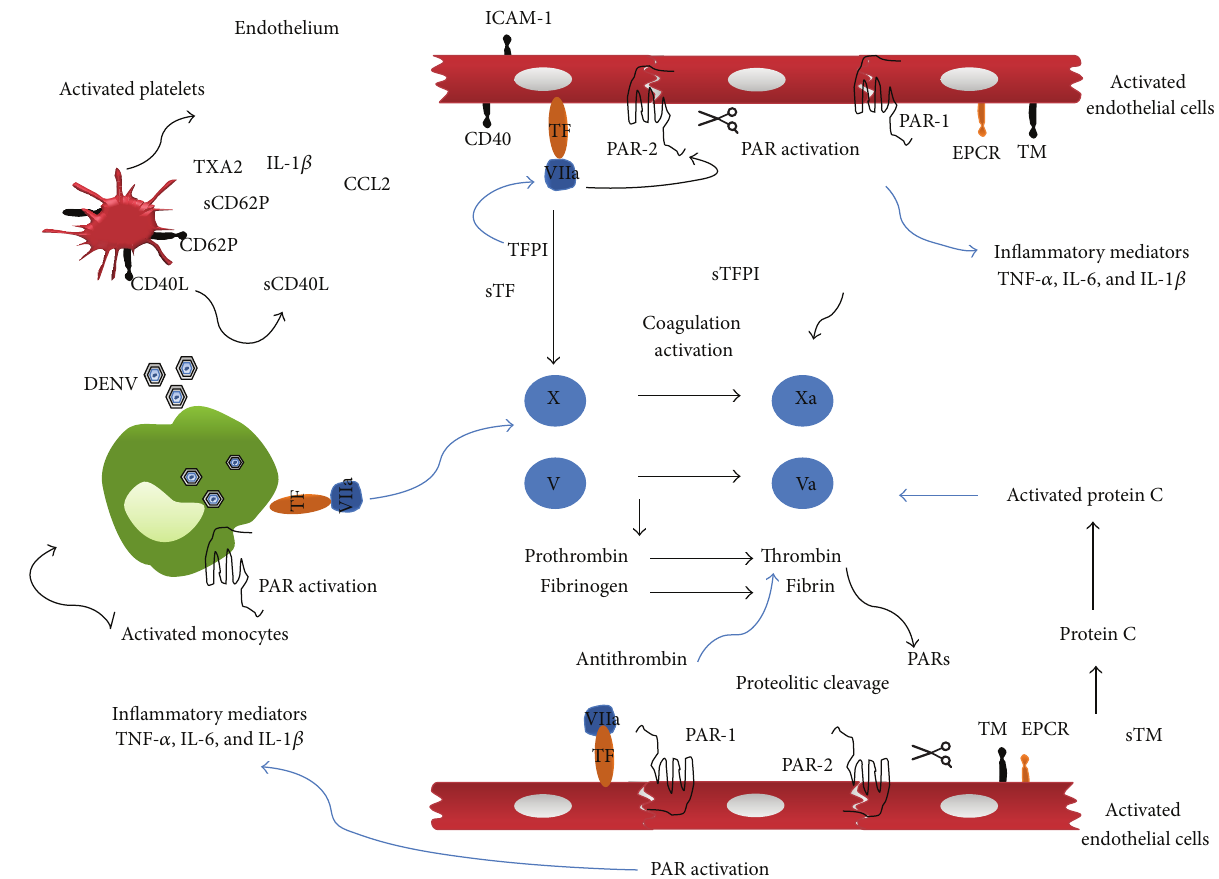
Figure 1: Coagulation and inflammatory response activation during dengue. DENV infection is often associated with coagulation disorders. Thecoagulationsystemisactivatedbythehostimmuneresponse.Theactivationofcoagulationsystemleadstothegenerationofthrombinand intracellular signaling through PAR; platelet and monocyte activation and recruitment; and increased TF expression on the endothelium and monocytes. The following anticoagulant pathways balance this system: the protein C system, antithrombin (AT), and Tissue Factor Pathway Inhibitor (TFPI). Increased CD62P expression in platelets from dengue patients indicates platelet activation and therefore favors homo- and heterotypic interactions with immune cells and endothelial cells. Additionally, CD40L (CD154) expressing platelets can interact with CD40 on endothelial cells, inducing upregulation of adhesion molecule (e.g., ICAM-1), chemokine secretion (e.g., CCL2), and leukocyte recruitment. Evidence of increased circulating TF levels in dengue patients and increased expression in monocytes from severe patients suggests its importance in disease pathogenesis. The release of inflammatory cytokines leads to activation of the coagulation cascade through the TF pathway. Coagulation factors (e.g., thrombin) activate PAR and amplify proinflammatory cytokine production (e.g., TNF- 𝛼 , IL-1 𝛽 , IL-6, and CCL2) and leukocyte migration to the infection site. EPCR: endothelial protein C receptor; TM: